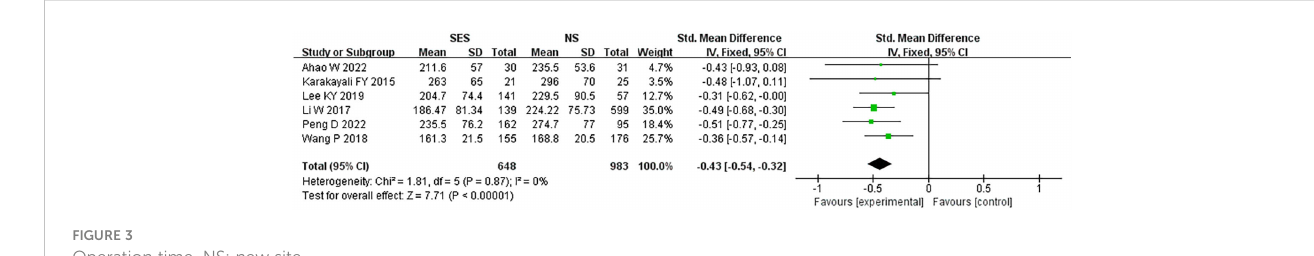
FIGURE 3 Operation time. NS: new site.